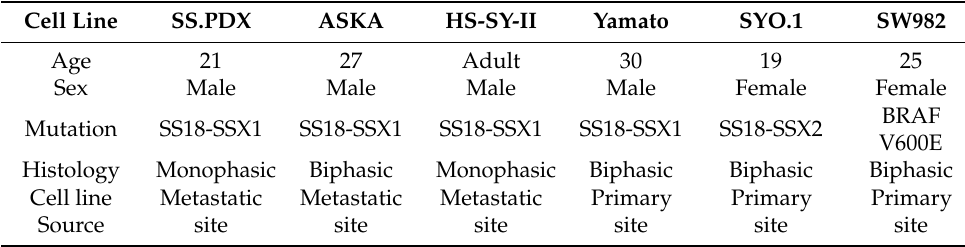
Table 1. Summary of cell